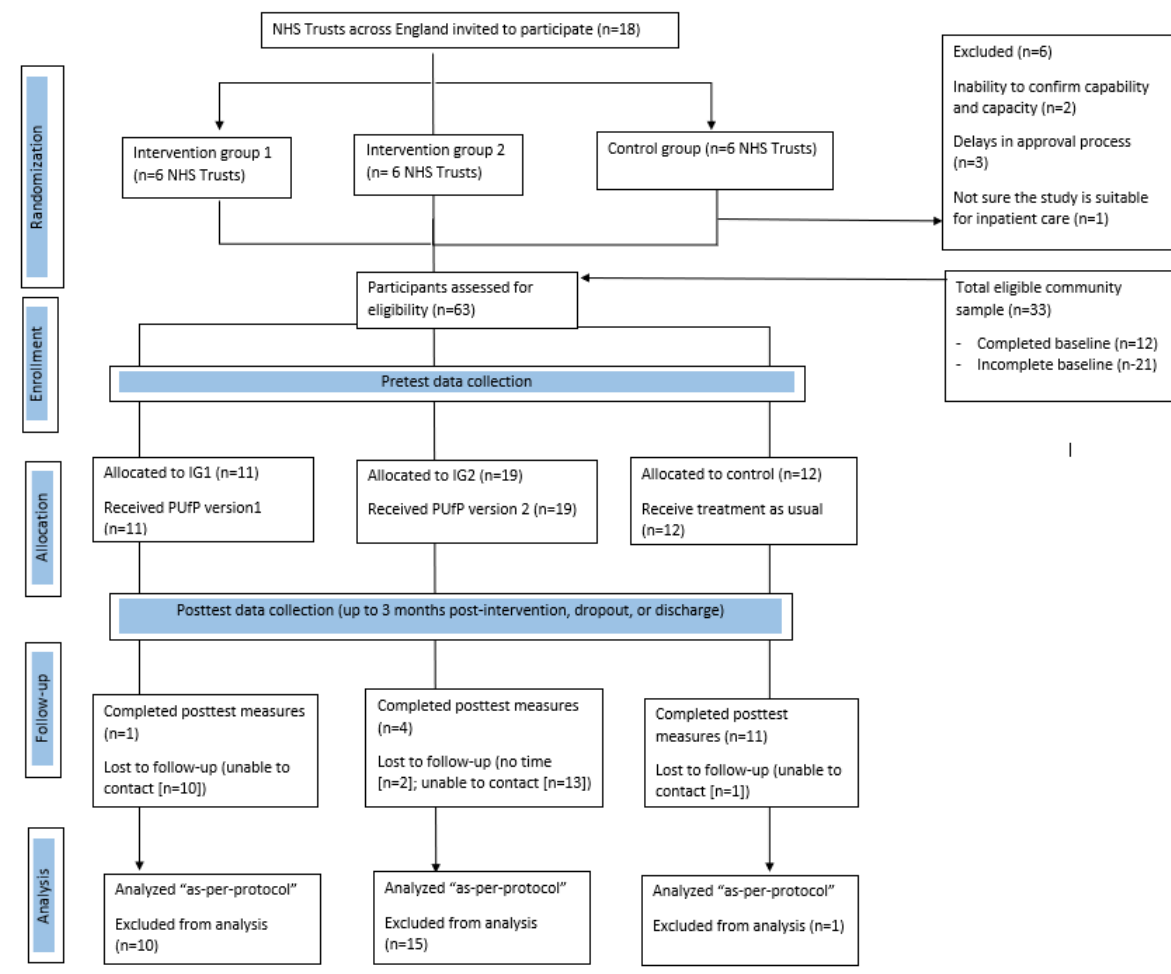
Figure 1. Consolidated Standards of Reporting Trials flowchart of participants in the quantitative study. IG1: intervention group 1; IG2: intervention group 2; NHS: National Health Service; PUfP: Power Up for